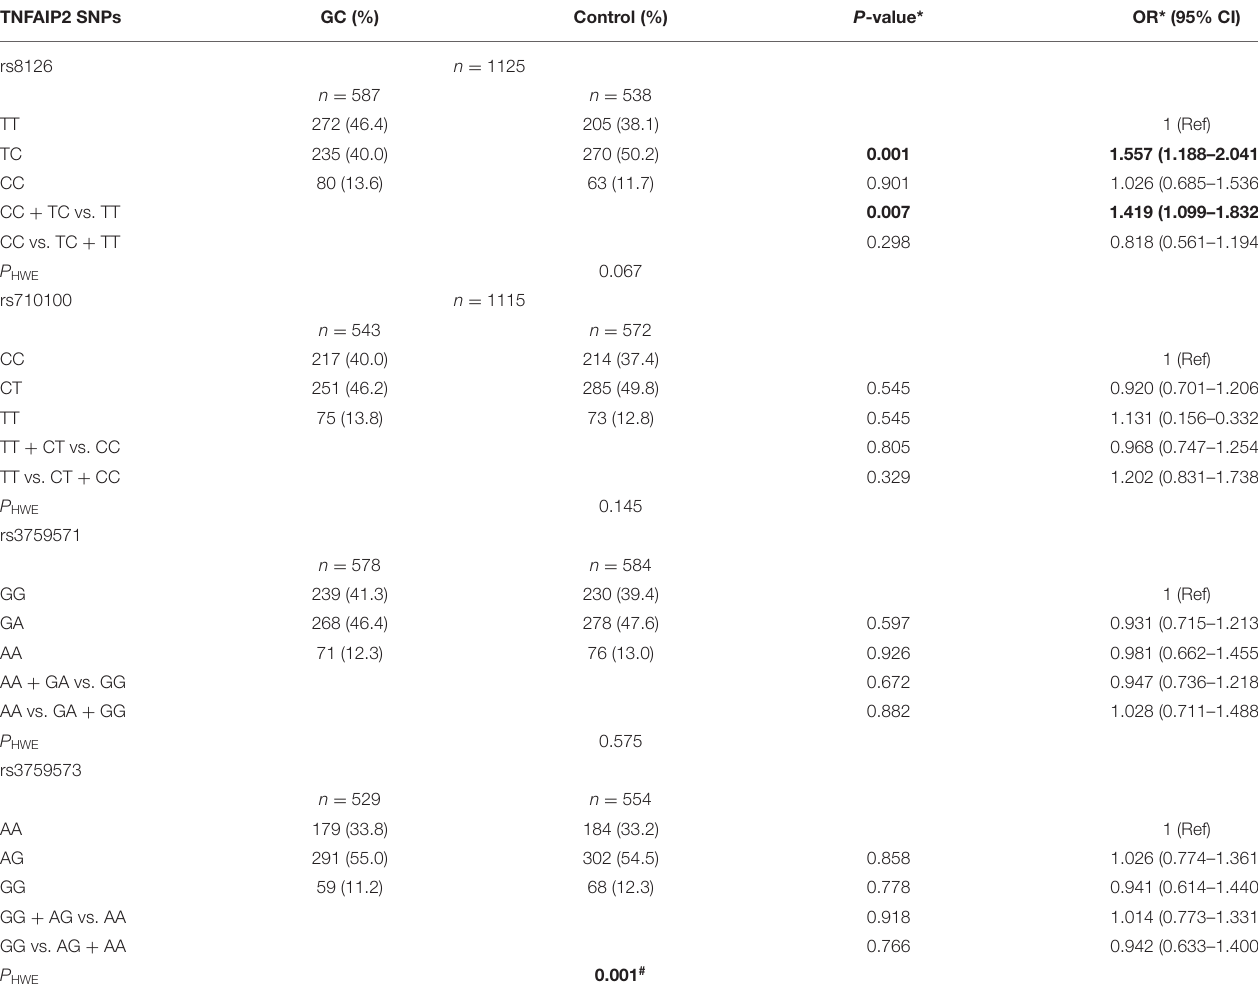
TABLE 2 | The correlation between TNFAIP2 TagSNPs and gastric cancer (GC) risk in the general population. TNFAIP2